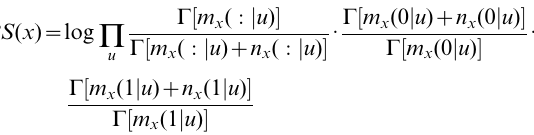
Figure S3 a) AIC score, and b) Bayesian score for human models M 0 to M 10 . The pDAGs associated with each model are identical to those obtained by the BIC score (Figure 2). (DOC) Figure S4 a) AIC score, and b) Bayesian score for rat models M 0 to M 10 . The pDAGs associated with each model are identical to those obtained by the BIC score (Figure 3), except for the M 8 model under the AIC scores, which is depicted in Figure S5. (DOC) Figure S5 pDAG for the rat M 8 model. a ) as obtained from the BIC and from the Bayes scores; b ) as obtained from the AIC score. The difference is in the single edge connecting C to D in the BIC and Bayes scores, which is replaced by an edge connecting C and E in the AIC score. Figure S6 Level of support of each edge in all individual best-fitting models with fixed number of edges. The results are for AIC scores in human. Figure S7 Level of support of each edge in all individual best-fitting models with fixed number of edges. The results are for Bayes scores in human. Figure S8 Level of support of each edge in all individual best-fitting models with fixed number of edges. The results are for AIC scores in rat. Figure S9 Level of support of each edge in all individual best-fitting models with fixed number of edges. The results are for Bayes scores in rat. (DOC) Table S1 Number and composition of the mRNA molecules collected for human and rat. Table S2 The -coefficient between the editing sites for (a) human, and (b) rat. All coefficients are significant (FDR corrected), except for the pair (D,E) in human and (A,E) in rat. Errors are standard deviations. Table S3 The estimated parameters of the best-fitting models in human. The models are shown in Figure 2. Table S4 The estimated parameters of the best-fitting models in rat. The models are shown in Figure 3. Table S5 Statistics on the individual best-models for AIC scores in human. The statistics for AIC is very similar to BIC, and we report here only those models for which the AIC scores behave differently from the BIC scores (changes are in red). The models are shown in Figure 3. Table S6 Statistics on the individual best-models for Bayes scores in human. The statistics for Bayes score is very similar to BIC, and we report here only those models for which the Bayes scores behave differently from the BIC scores (changes are in red). Table S7 Statistics on the individual best-models for BIC scores in rat. For each family of models with the